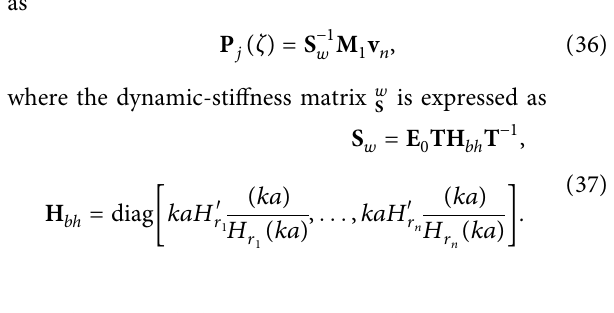
l for different values of H with σ 1 versus 0